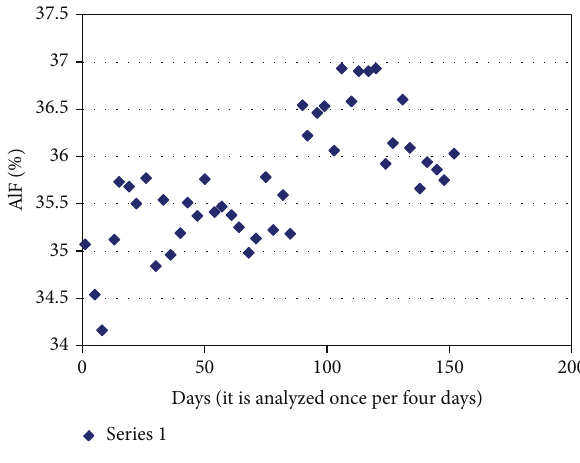
Figure 3: The change of concentration of AlF 3 .